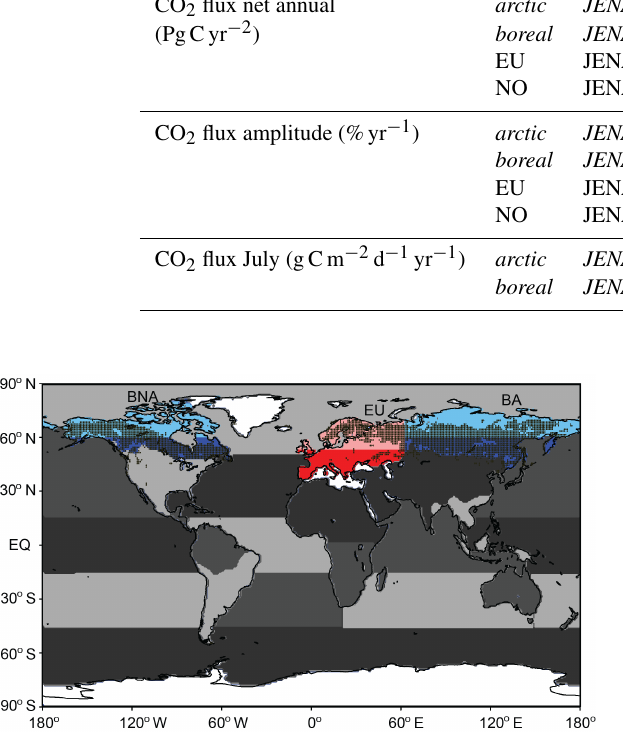
Figure 1. The major land and ocean basis regions used in the RIGC inversion based on the TransCom3 regions. The Jena inversion was done on a ∼ 4 × 5 ◦ grid and aggregated to these regions. The north- ernmost land regions are shown in color. The two zones that we dis- cuss in this analysis cover boreal North America and boreal Asia and are marked in shades of blue, with the arctic zone (>60 ◦ N) in light blue and the boreal zone (50–60 ◦ N) in dark blue. The Eu- ropean basis region, in red, is not divided at 60 ◦ N in the RIGC inversion and therefore is not included in this analysis. Stippling indicates the boreal forest biome based on the Global Land Data